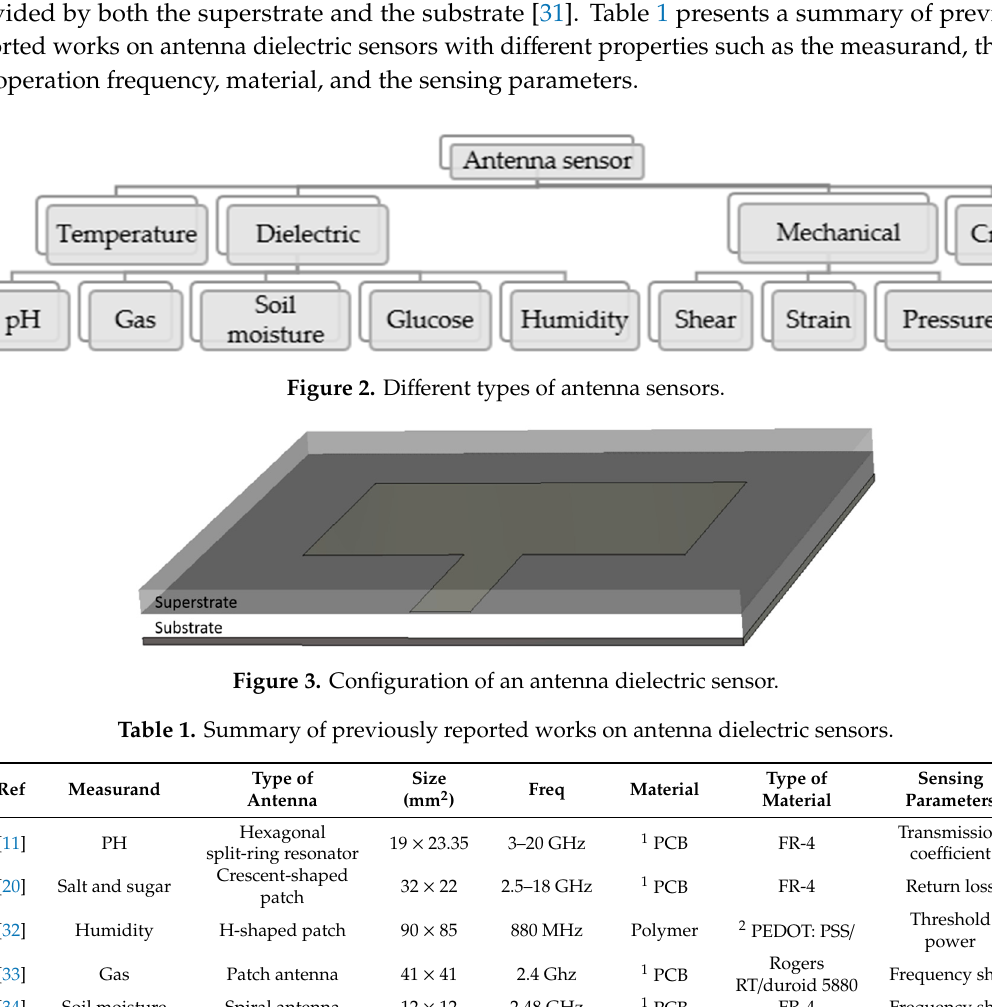
Figure 2. Different types of antenna sensors.